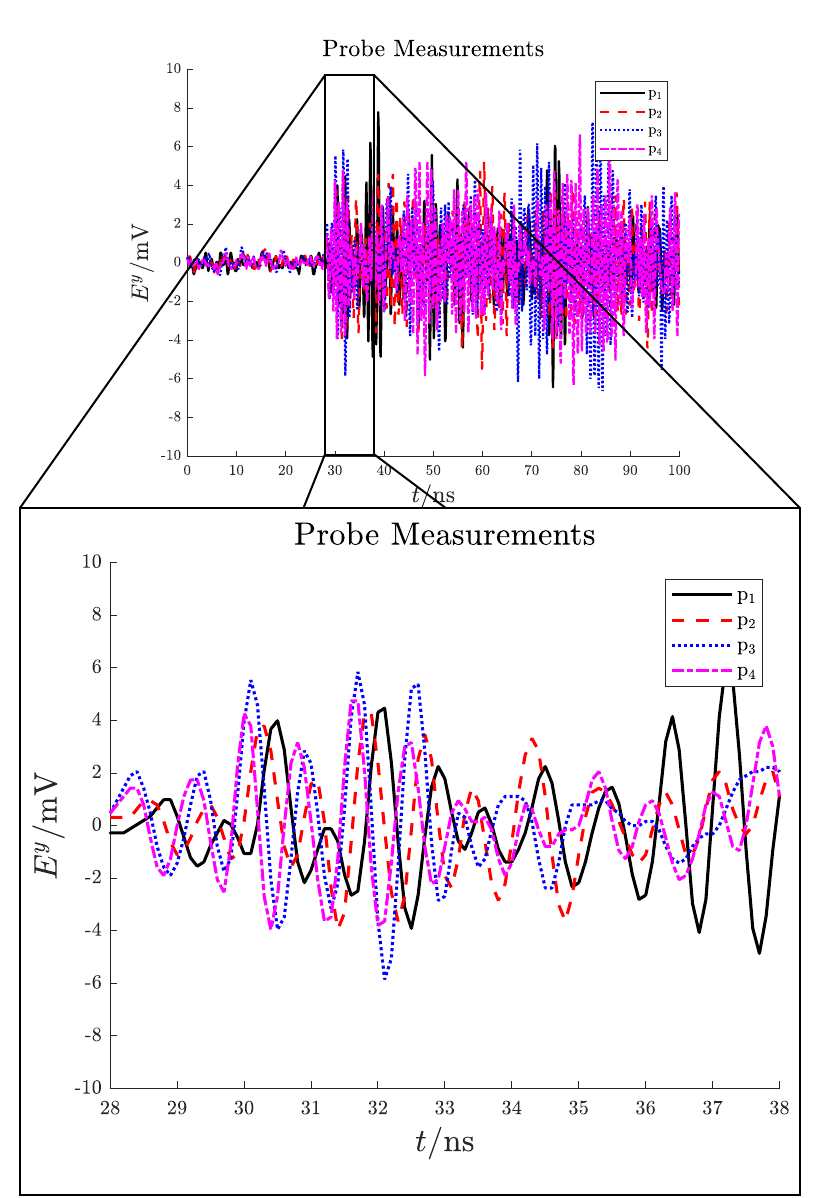
Figure 13. Test case 1. Electric field signals detected by the antennas in